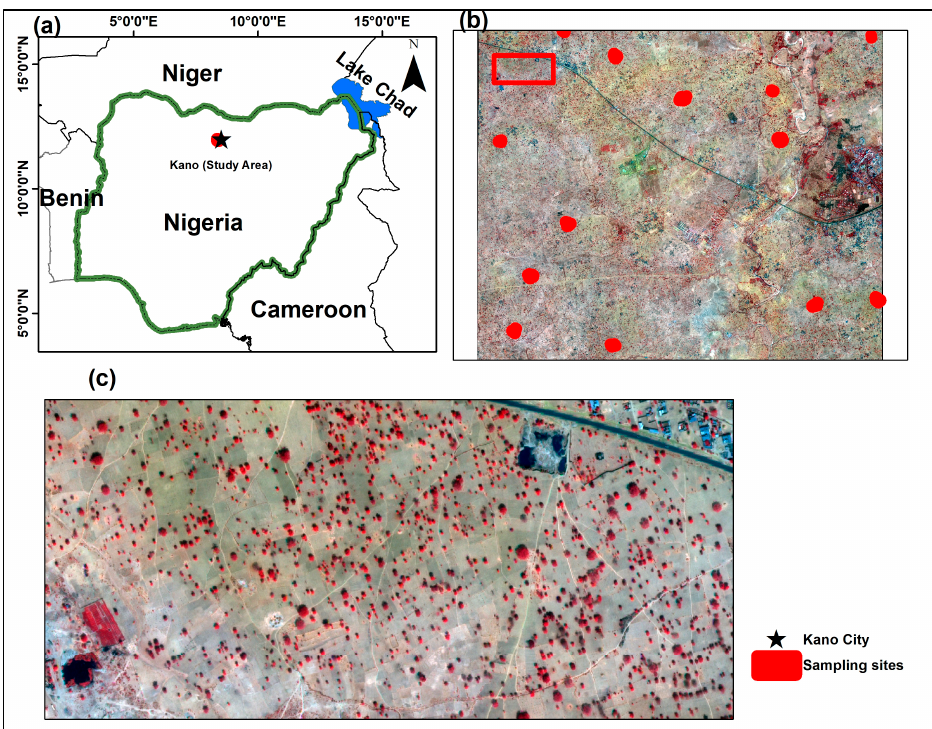
Figure 1. ( a ) Location of study area; ( b ) WV ‐ 2 image of study area with location of the sampled sites in the field; ( c ) zoomed ‐ in view of a pansharpened WV ‐ 2 image. Table 1. Specifications of the WorldView-2 satellite